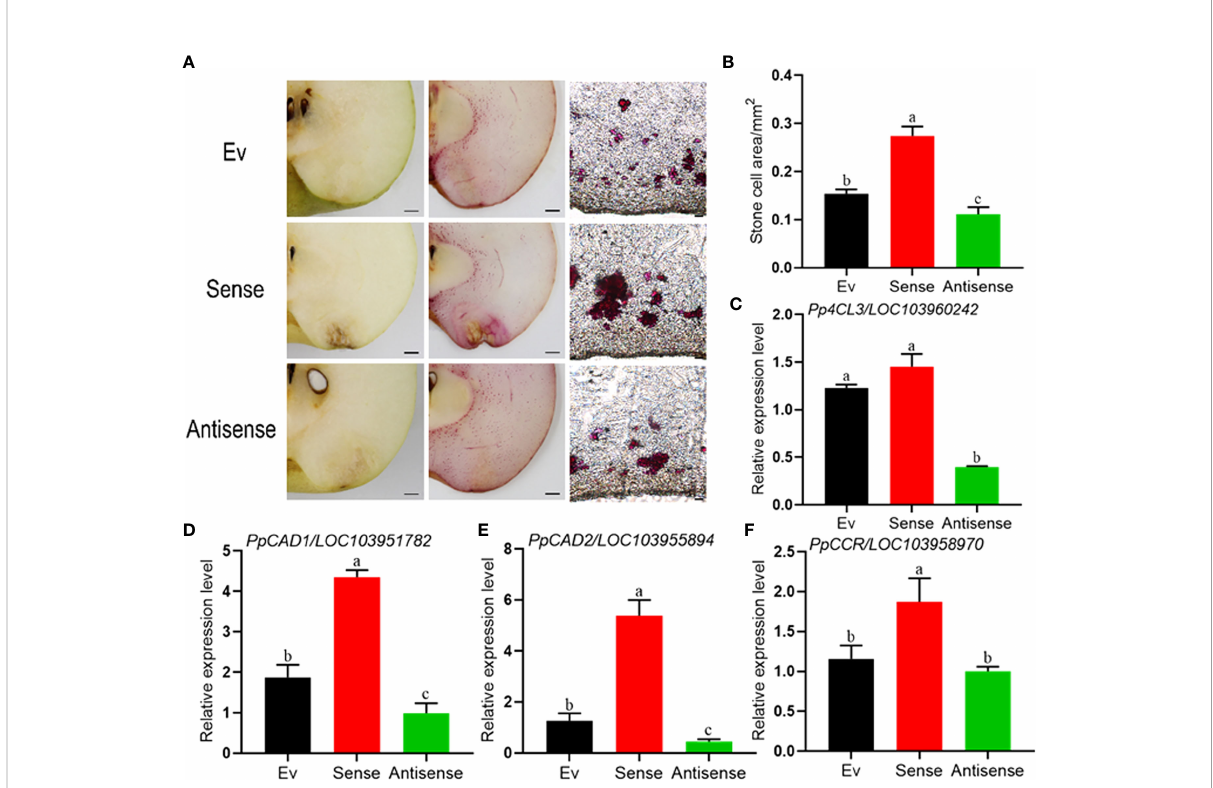
FIGURE 5 Transient overexpression of sense- PpERF1b-like promotes lignin synthesis and the relative expression levels of lignin synthesis related genes in pear fruit surrounding the site of in fi ltration. (A) Lignin staining and frozen section staining in the injection site of transient overexpression fruit. Ev: Empty vector, Sense: sense- PpERF1b-like , Antisense: antisense- PpERF1b-like . Scale bars = 100 m m. (B) The area of stone cells in the injection site. Data are given as mean ± SD (n=4). Bars with different letters indicate signi fi cant differences between groups ( p < 0.05; Student ’ s t-test